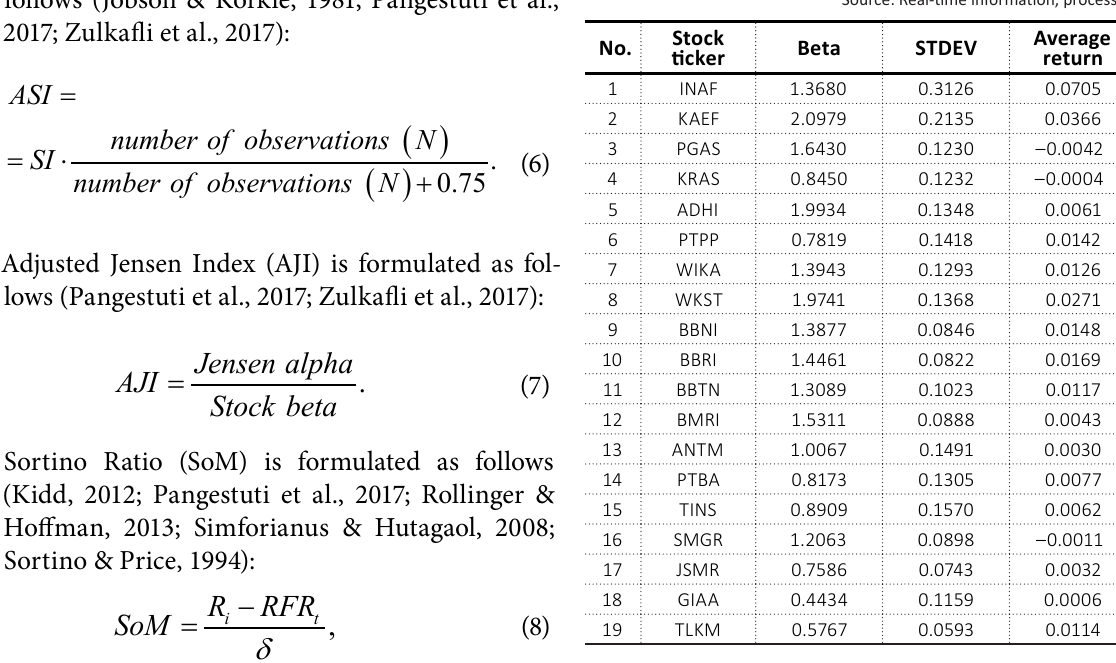
Table 2. Beta, standard deviation, and